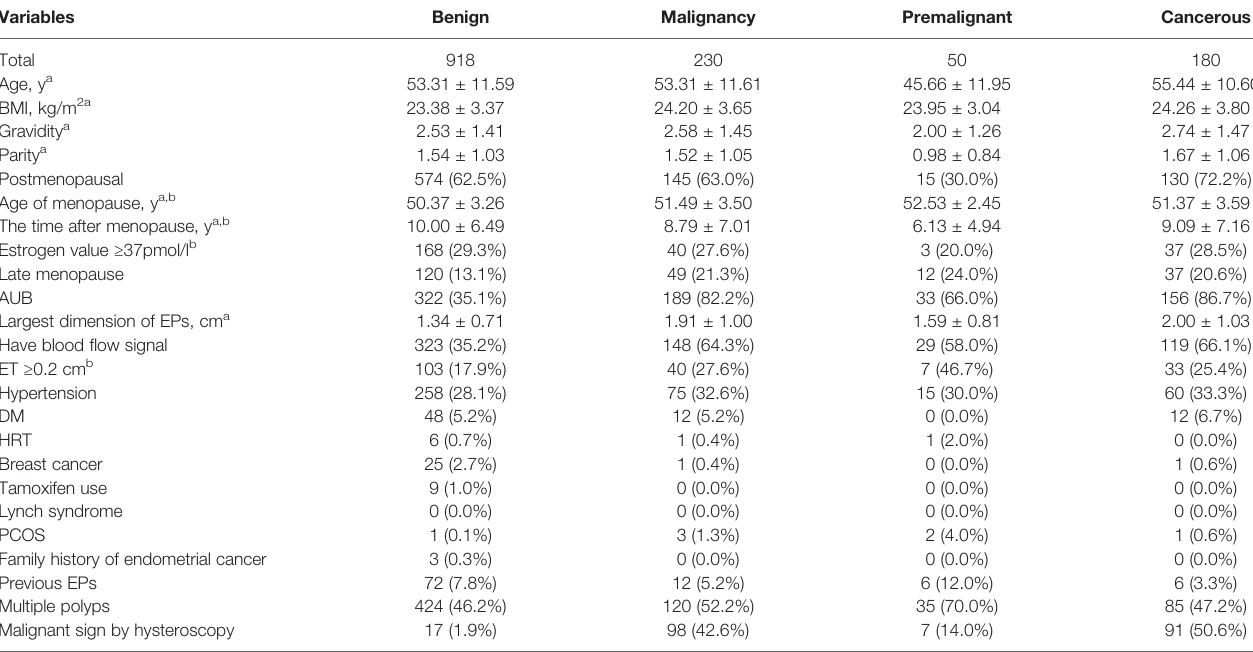
TABLE 2 | Demographic and clinical data in benign and malignancy group in training set. Variables